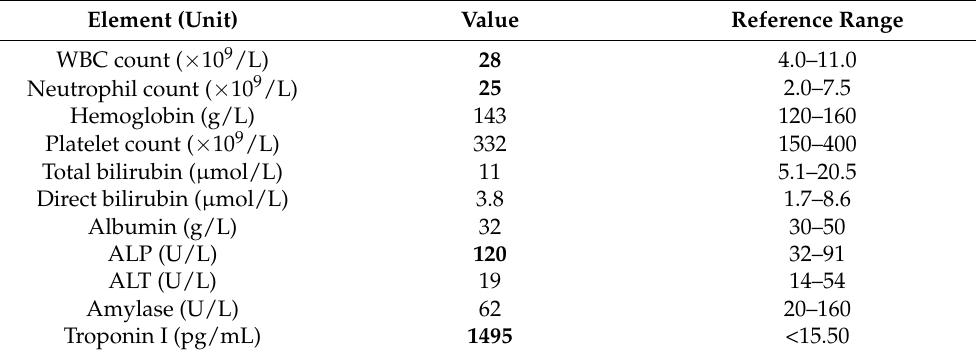
Table 1. Summary of the laboratory investigations of the first